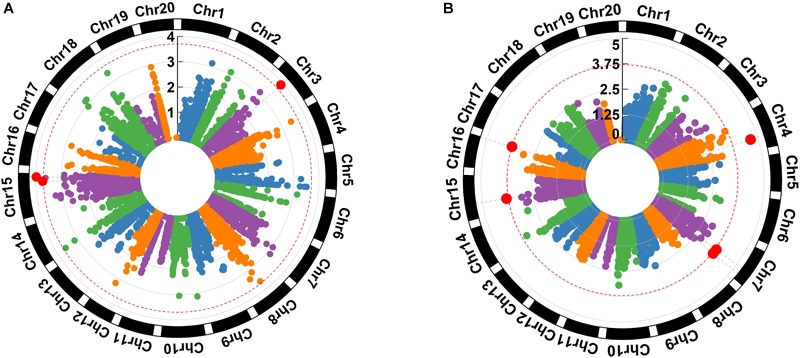
Genetic architecture for photosynthesis (A) and intrinsic water use efficiency (B) in a phenology-controlled soybean panel. Three hundred and eighty-three cultivars and three environments. Chr indicates the chromosome, the red dashed circle represents the threshold expressed as –log p-value, and red dots correspond to the significant SNPs.